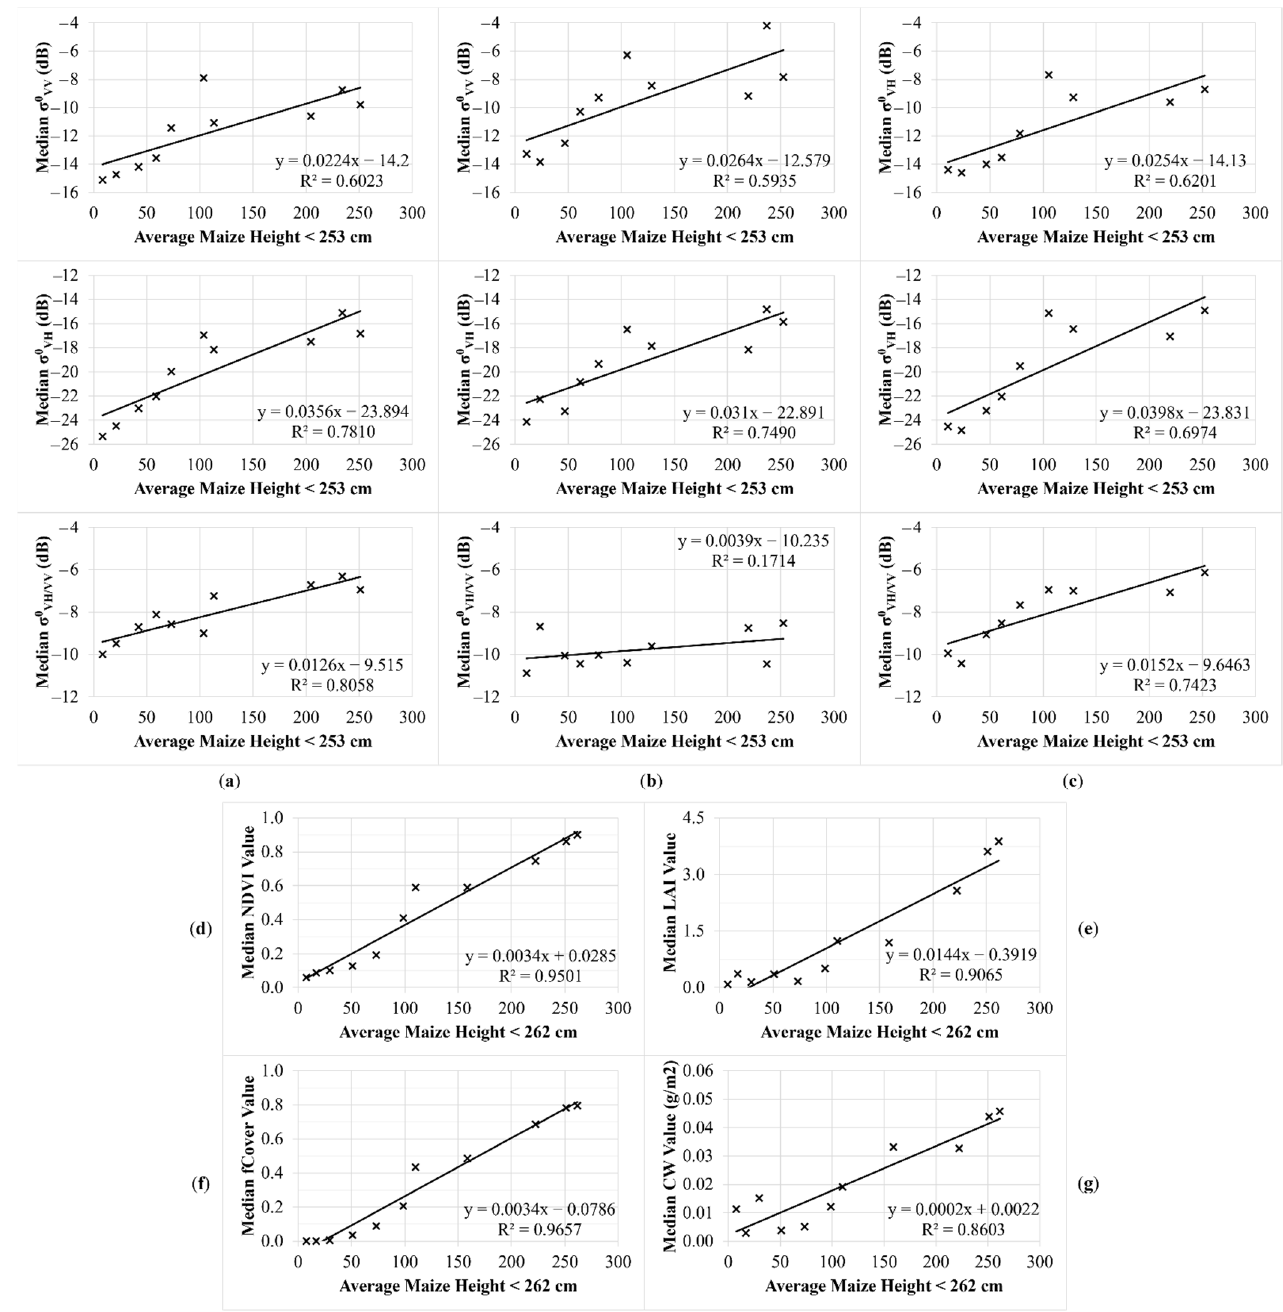
Figure 11. Coefficient of determination (R 2 ) between backscatter values ( σ 0VV , σ 0VH, and σ 0VH/VV ) obtained from ( a ) Ascending-58 orbit, ( b ) Ascending-160 orbit, ( c ) Descending-65 orbit and maize height; and coefficient of determination (R 2 ) between ( d ) NDVI, ( e ) LAI, ( f ) fCover, ( g ) CW values and maize height.